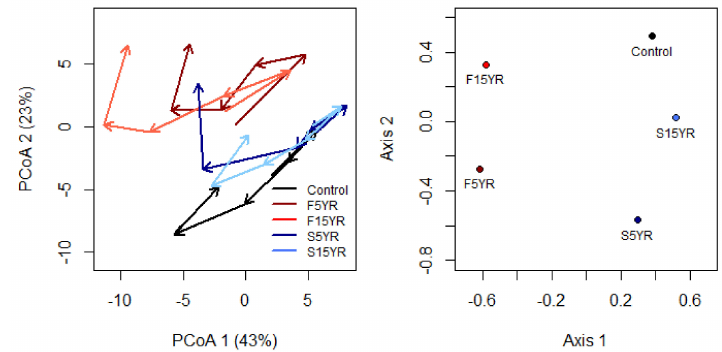
Figure 3. Treatment-level uncentered understory community trajectories (left panel) and dissimilarities between trajectories (right panel). Principle Coordinates Analysis (PCoA) ordination of community trajectories indicated by arrows, with 2002 as the starting year, 2004, 2007, 2009, and 2012 as midpoints, and 2015 as the end year of vectors. Percentages on PCoA axes are the percentage of variance described for those ordination axes. Non-metric multi-dimensional scaling (nMDS) ordinations of dissimilarities between uncentered trajectories, with treatments closer together indicating more similar community trajectories over time. Control = Unburned, S15YR = Spring 5 year reburns, S15YR = Spring 15 year reburns, F5YR = Fall 5 year reburns, and F15YR = Fall 15 year